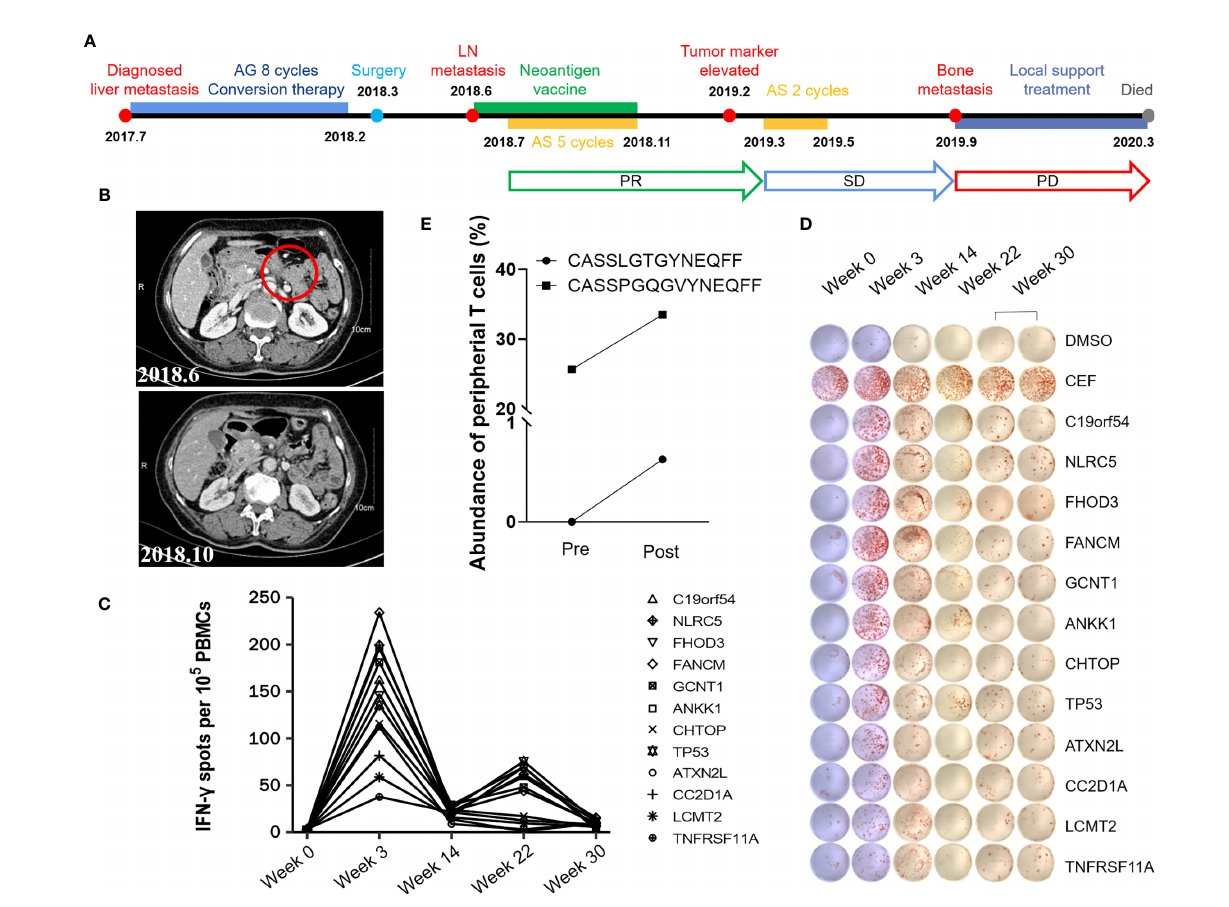
FIGURE 3 | A case report of Patient P01. (A) Treatment timeline of P01. (B) Comparison of lymph node before & after vaccination by imaging. (C, D) Ex vivo IFN- g ELISpot of PBMCs was performed with peptides at different time points. The dimethyl sulfoxide (DMSO) group was used as the negative control and mixed peptides from CEF (including peptides of cytomegalovirus, Epstein – Barr virus and in fl uenza virus) were used as the positive control. (E) Increased abundance of peripheral T cell clones after vaccination was detected by TCR